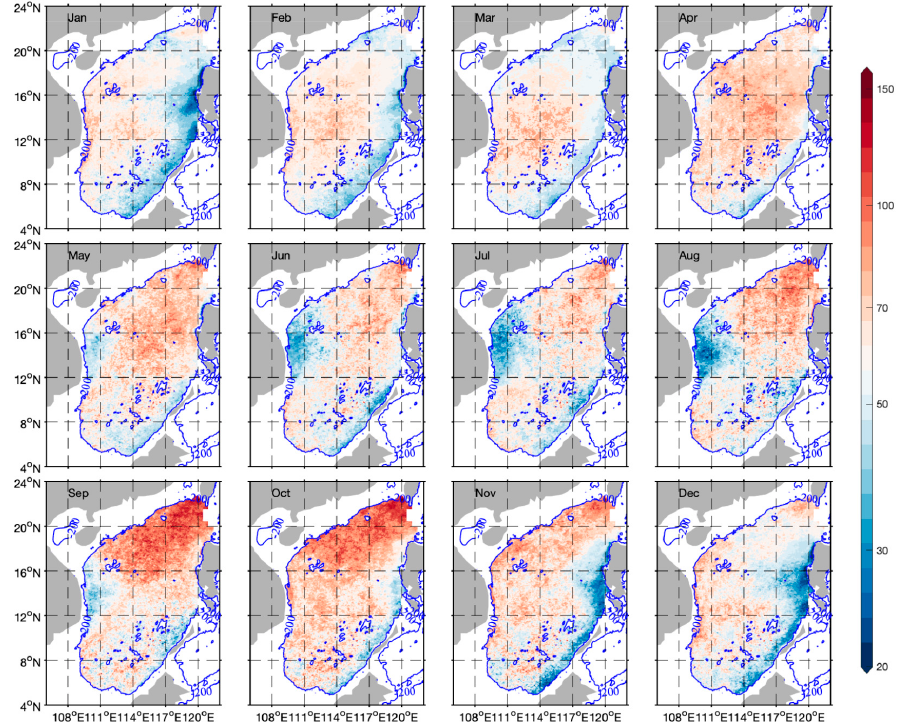
Figure 8. Monthly mean climatological distribution of the θ in the South China Sea (September 1997 to December 2019). The blue line shows the 200-m